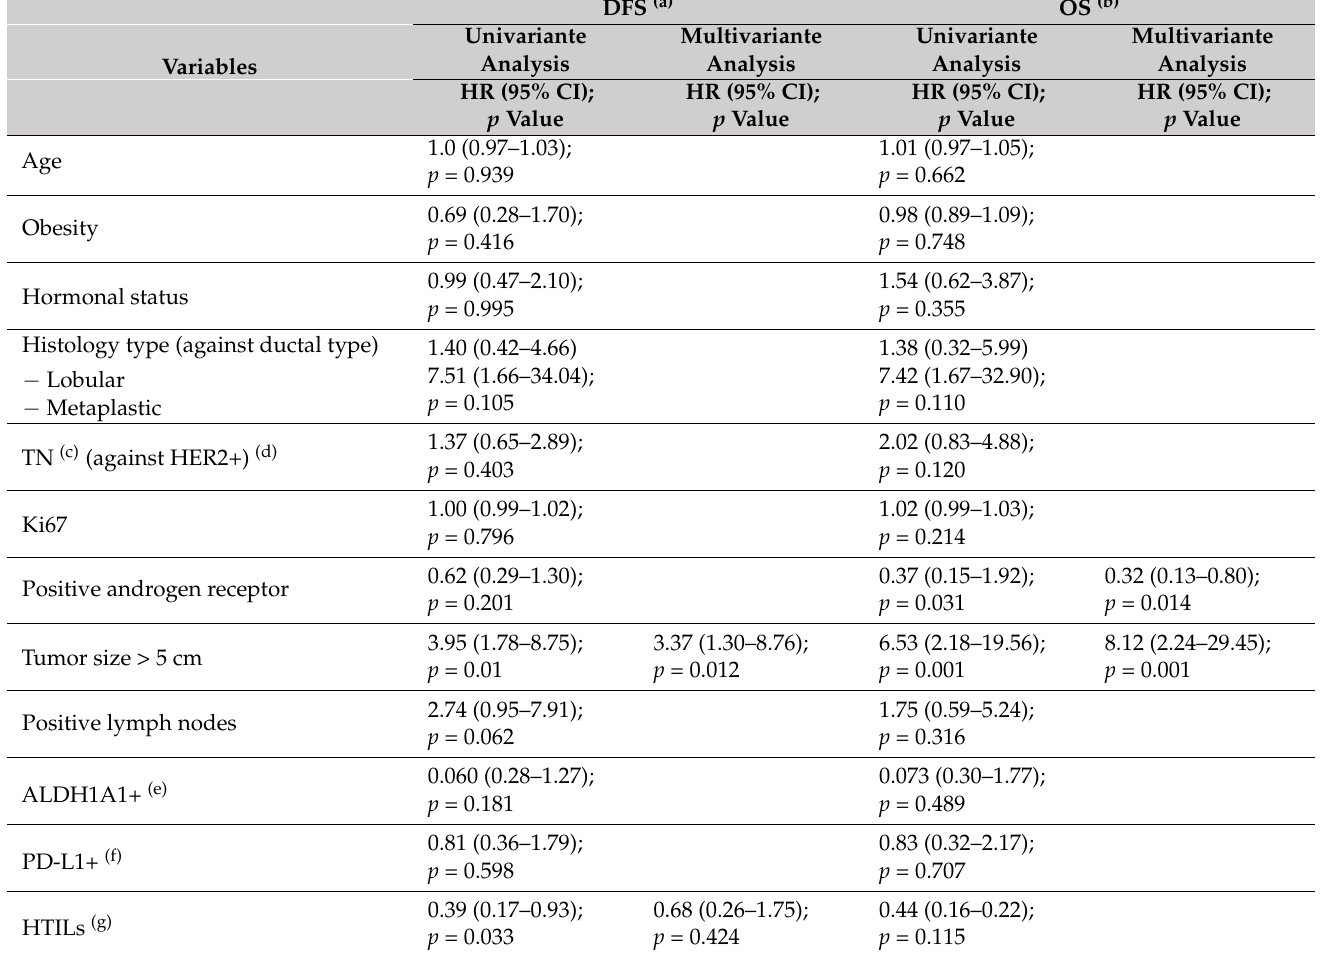
Table 5. Predictors of disease-free and overall survival in breast cancer